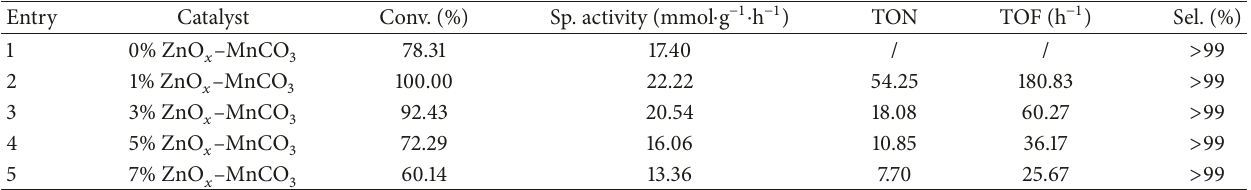
100 ∘ C, 10mL of toluene, and 18min of reaction time.